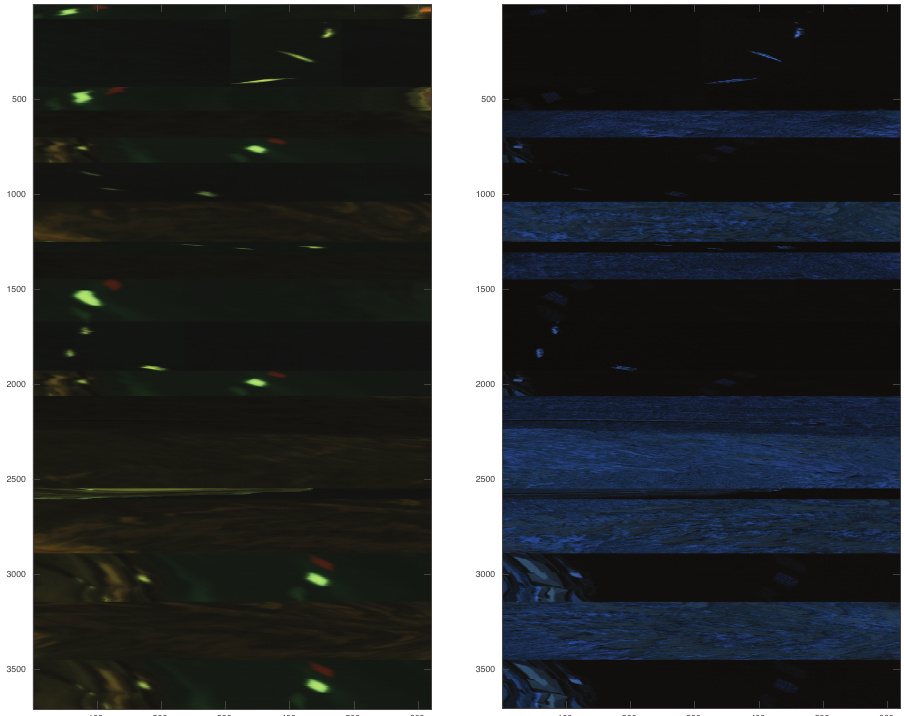
Figure 7. Reconstructed image for each hyperspectral camera used. Left image shows the Specim